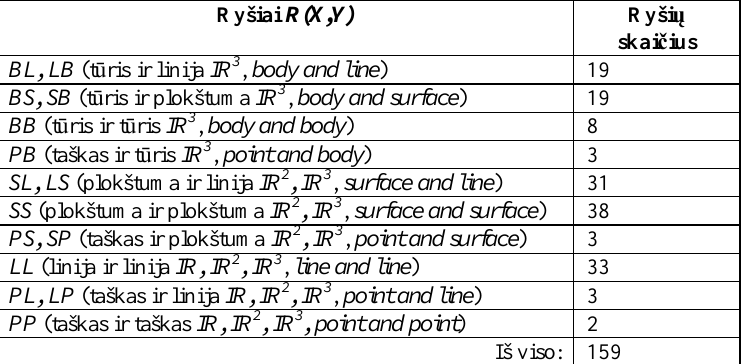
Table 2. Relations between objects in IR , IR 2 , IR 3 spaces Ryšiai R(X,Y) Ryši ų skai č ius BL, LB (t ū ris ir linija IR 3 , body and line ) 19 BS, SB (t ū ris ir plokštuma IR 3 , body and surface ) 19 BB (t ū ris ir t ū ris IR 3 , body and body ) 8 PB (taškas ir t ū ris IR 3 , point and body ) 3 SL, LS (plokštuma ir linija IR 2 , IR 3 , surface and line ) 31 SS (plokštuma ir plokštuma IR 2 , IR 3 , surface and surface ) 38 PS, SP (taškas ir plokštuma IR 2 , IR 3 , point and surface ) 3 LL (linija ir linija IR, IR 2 , IR 3 , line and line ) 33 PL, LP (taškas ir linija IR, IR 2 , IR 3 , point and line ) 3 PP (taškas ir taškas IR, IR 2 , IR 3 , point and point ) 2 Iš viso: